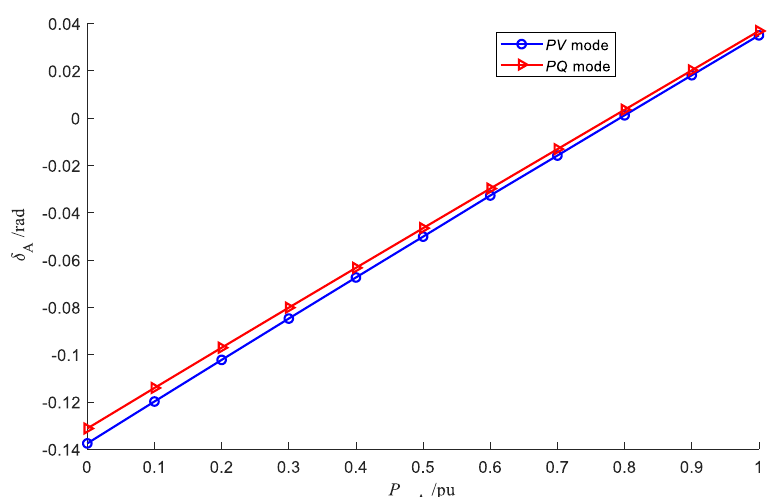
Figure 4. P pvA — δ A (active output of PV station A—voltage phase angle of POI_A) curve.